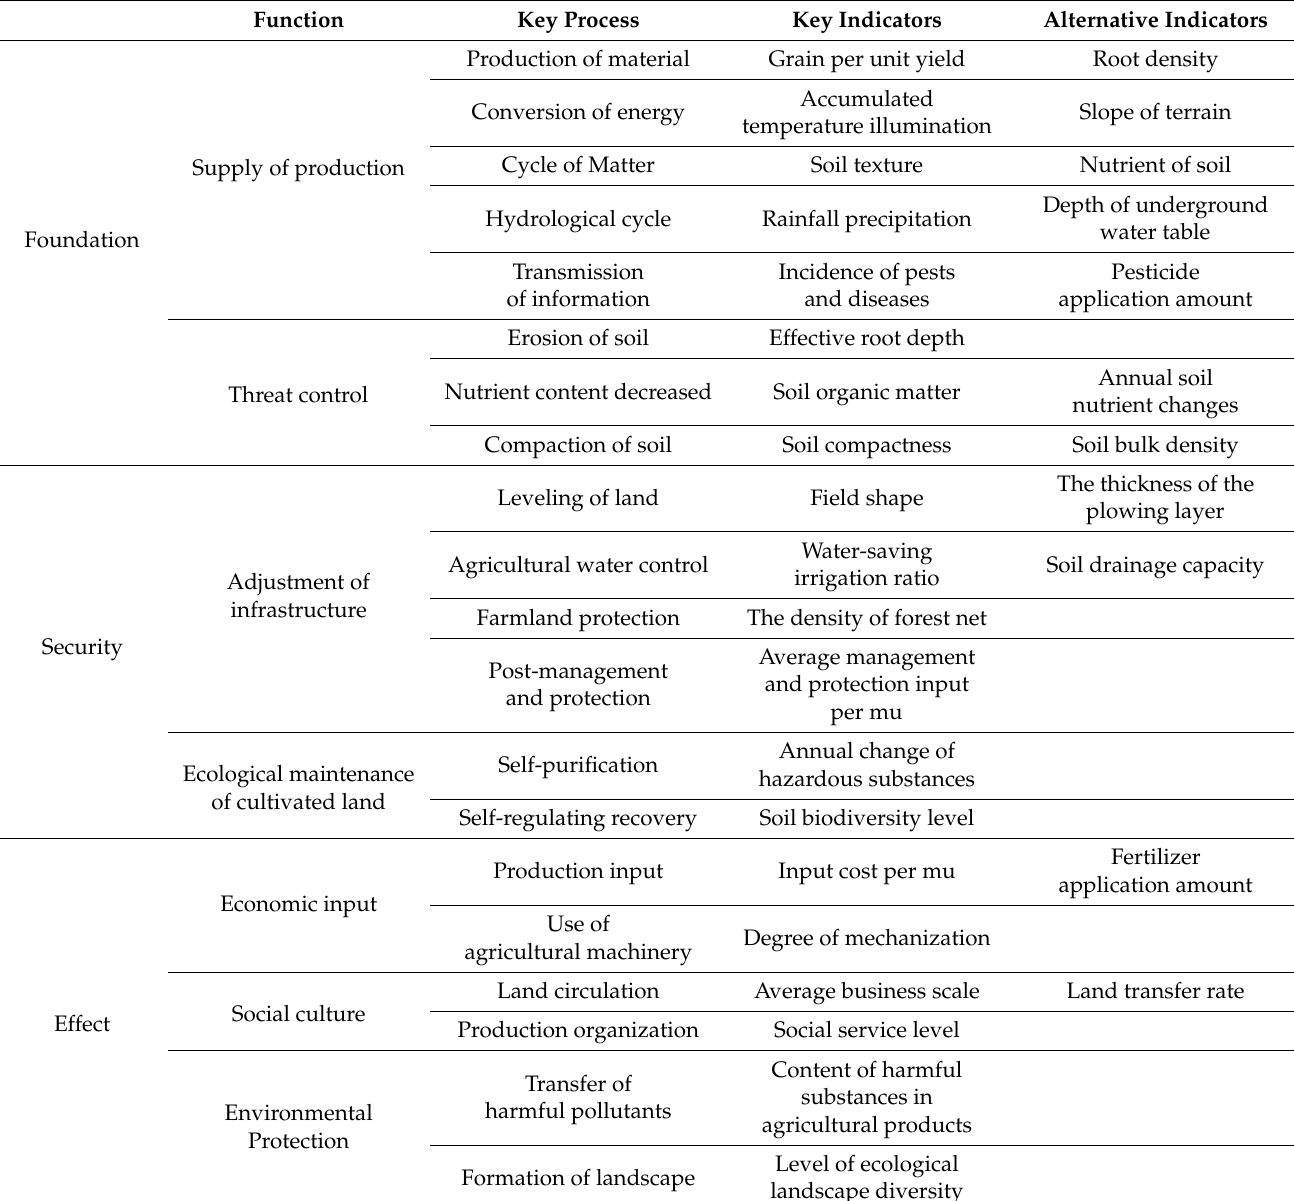
Table 2. Index system of cultivated land quality evaluation in black soil region with productivity as the